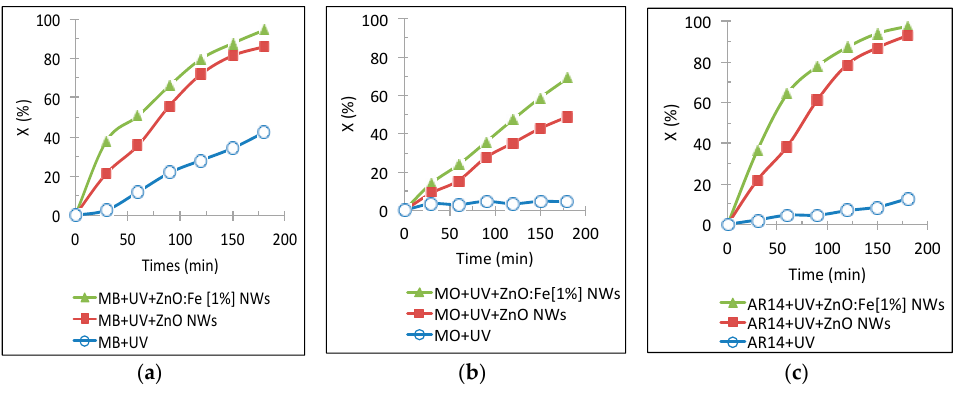
Figure 6. Photo-degradation rate evolution of the dye solutions: methylene blue (MB) ( a ); methyl orange (MO) ( b ); acid red 14 (AR14) ( c ) by photocatalysis in the presence of ZnO:Fe NWs, ZnO NWs and without ZnO, respectively.